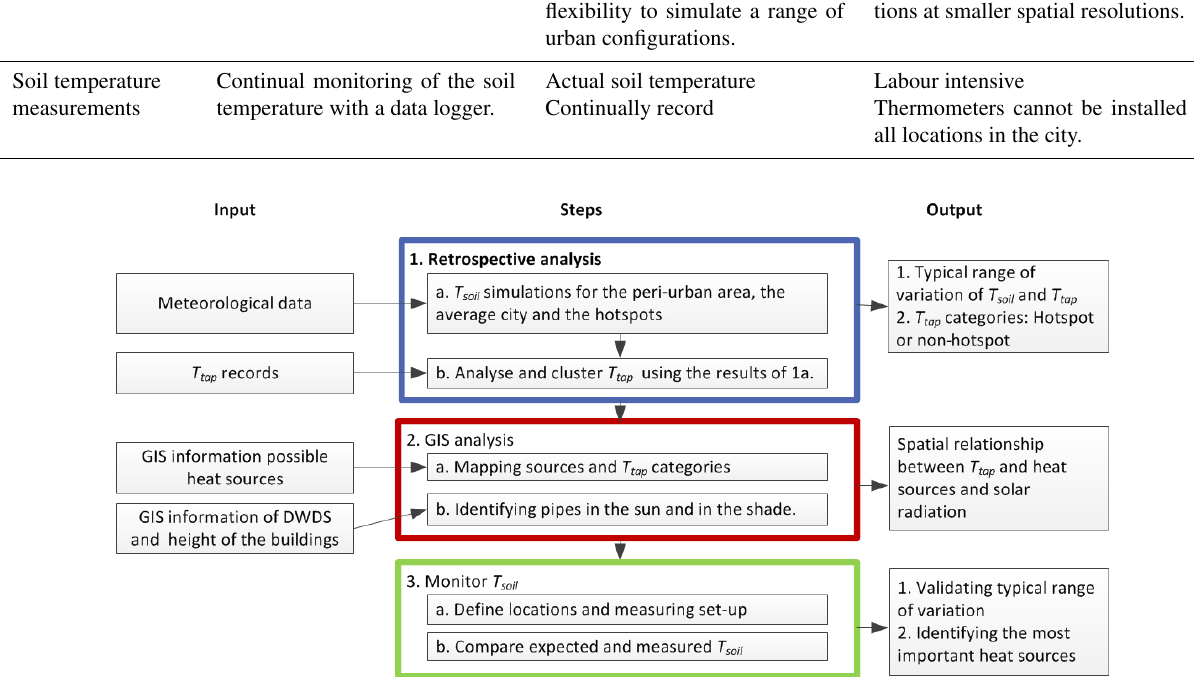
Figure 1. Proposed method to identify heat sources and urban characteristics that locally influence the soil temperature.